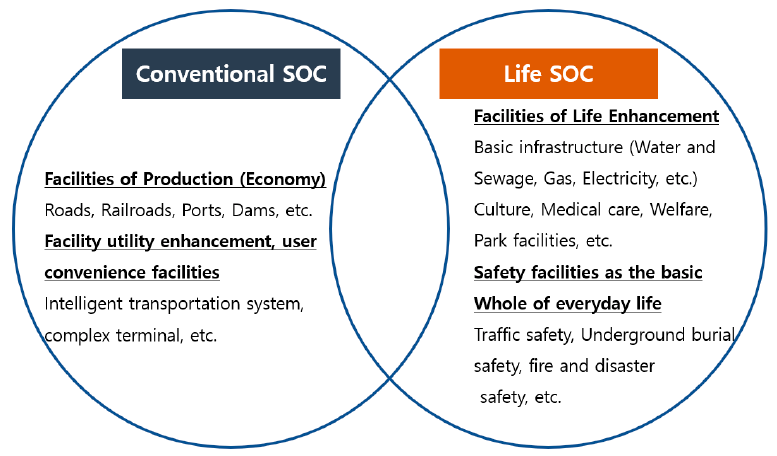
Figure 1. Scope of basic living infrastructure. Social Overhead Capital (SOC).